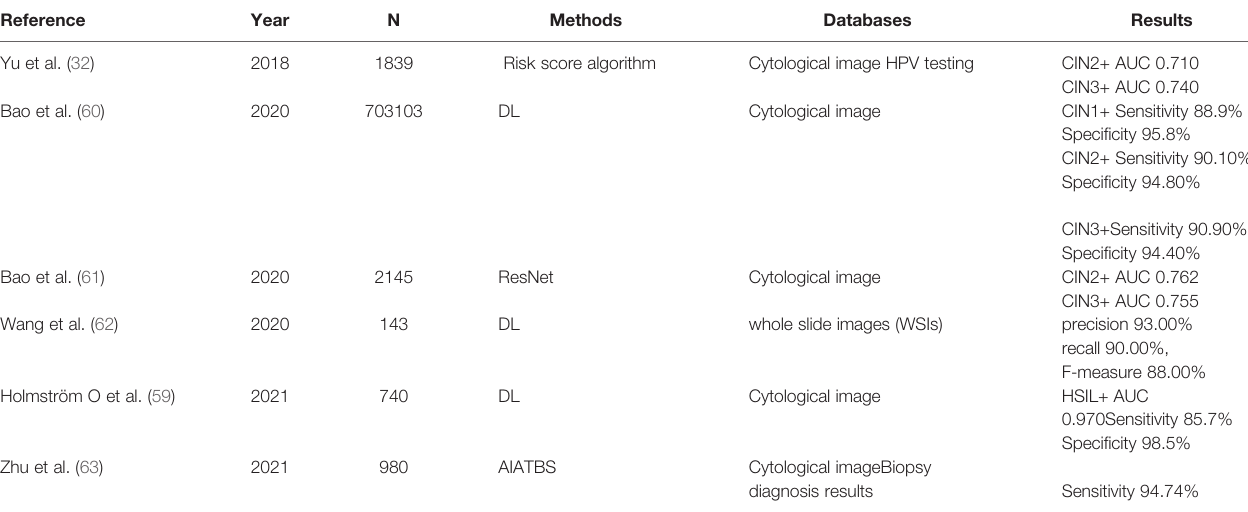
TABLE 5 | Application of AI in cytology to detect